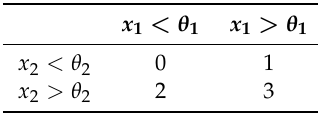
Table A1. Feature partitioning for a two-feature decision tree, with 2 2 = 4 possible partitions. Each partition is labelled using a number between 0 and 3. The threshold values θ decide which partition each sample falls under.